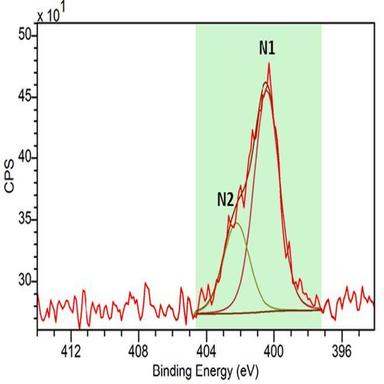
The high resolution spectra of N1s on the top surface.